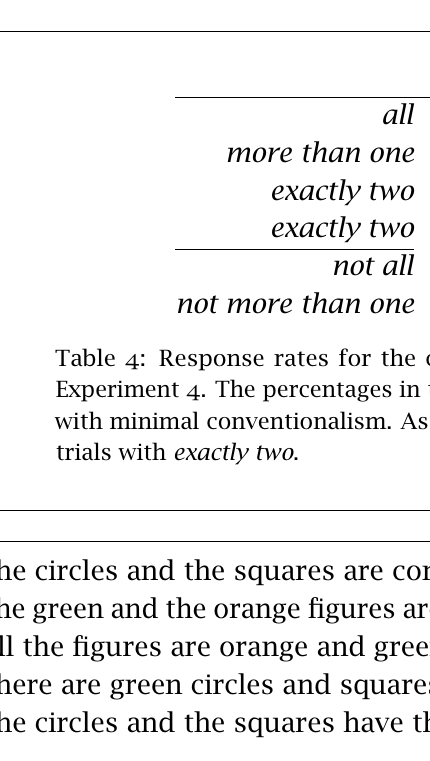
Table 5 : Response rates for the ambiguous control items in Experiment 4